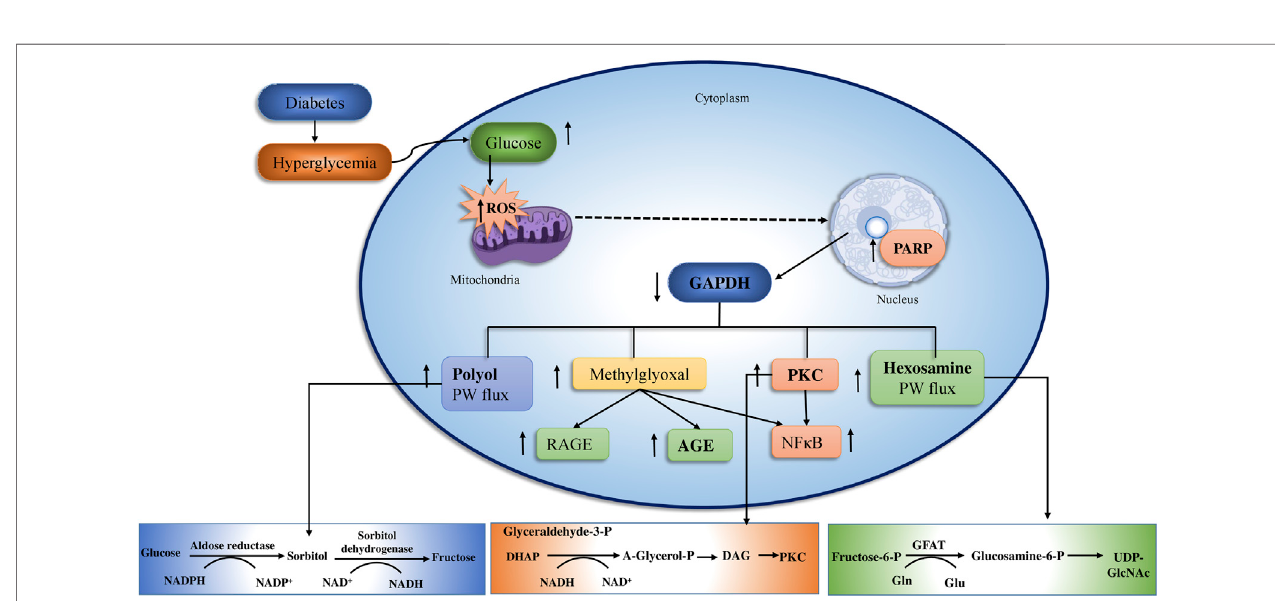
FIGURE 3 | The above fi gure depict the underlying pathway of hyperglycemia-induced mitochondrial dysfunction. Oxidative stress and vascular endothelial dysfunction Four major mechanisms connected to vascular endothelial cell failure include PKC, AGEs/RAGE, polyol, and hexosamine. The polyol and AGEs/RAGE pathwaysincreaseROSlevelsinendotheliacells,thatactivatesNF- κ B,ultimatelyinducesin fl ammationandthrombosisinvascularendotheliabyraisingthetranscription of VEGF, VCAM-1, and ET-1. (adopted from Brownlee, 2001).